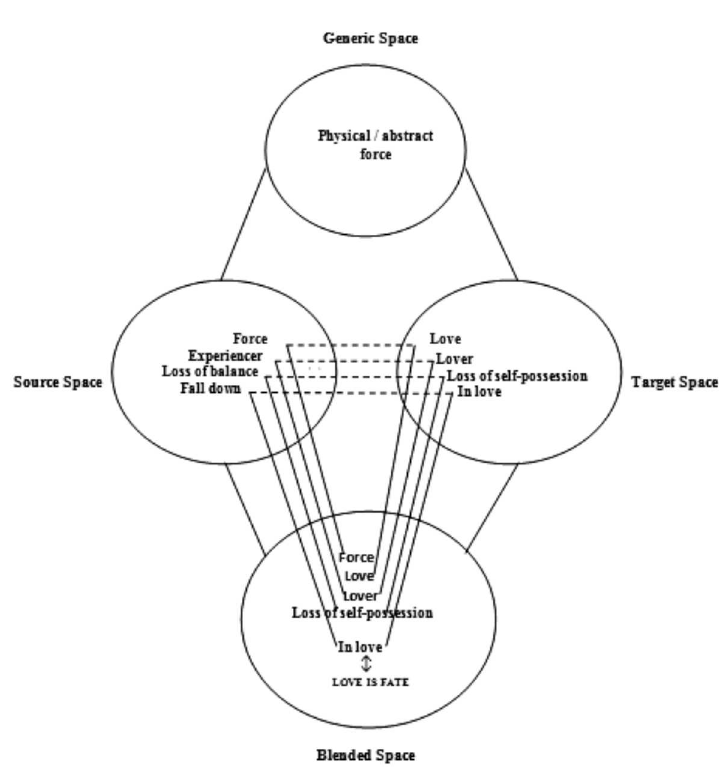
Figure 2. The LOVE IS FATE metaphor The extent to which the LOVE IS FATE metaphor can be said to be linked back to the generic-level metaphor LOVE IS A NATURAL FORCE depends on how the concept FATE is thought of within a given culture. In Western cul- ture, FATE is conceptualized as a supernatural power governing the course of events outside persons’ control. It lends itself in this respect as an instance of the more schematic concept of NATURAL FORCE . By that token, the lower- level metaphor LOVE IS FATE functions as an instance of the generic-level metaphor LOVE IS A NATURAL FORCE . Nonetheless, despite their metaphor- ical relatedness, they should not be put on a par as regards the role each plays in the metaphorical meaning of the expression. Central to the use of metaphors, indeed, is our intention to convey special meanings, along with various metaphorical inferences. For this reason, we single out the right metaphorical expressions for the purposes of expressing the intended meanings. In this case, the use of the metaphorical expression in (21) is nei- ther arbitrary nor a matter of whim. Rather, the speaker picks it out